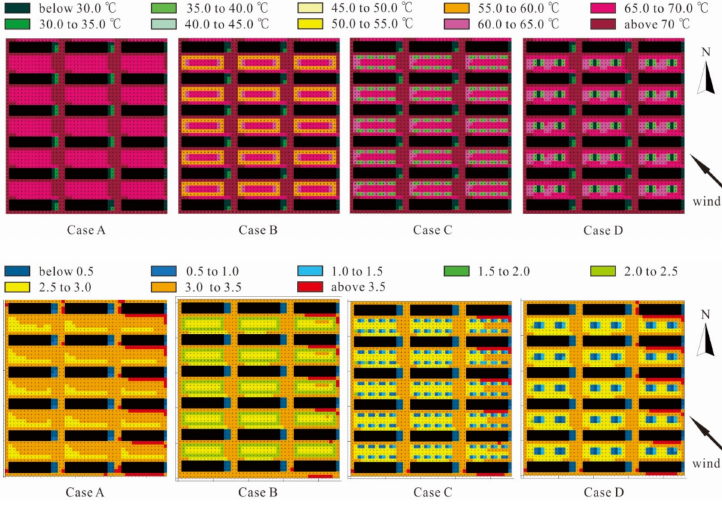
Figure 13. Contours of MRT ( top ) and PMV ( bottom ) at pedestrian height on 23 June at